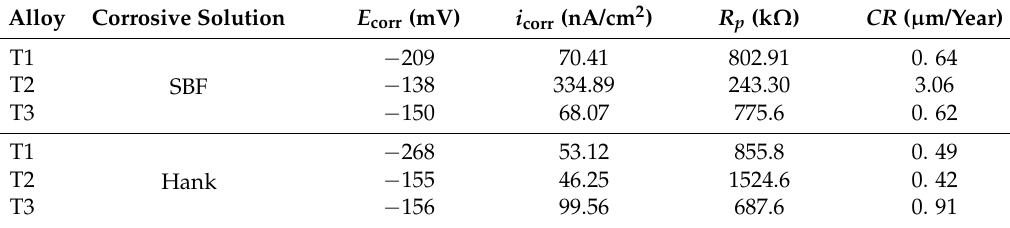
Figure 8. Potentiodynamic polarization curves of the investigated alloys in ( a ) SBF and ( b ) Hank solution. Table 4. Electrochemical parameters of the T1, T2, and T3 alloys in SBF and Hank solution: open circuit potential ( E OC ), corrosion potential ( E corr ), corrosion current density ( i corr ), polarization resistance ( R p ), corrosion rate ( CR ).